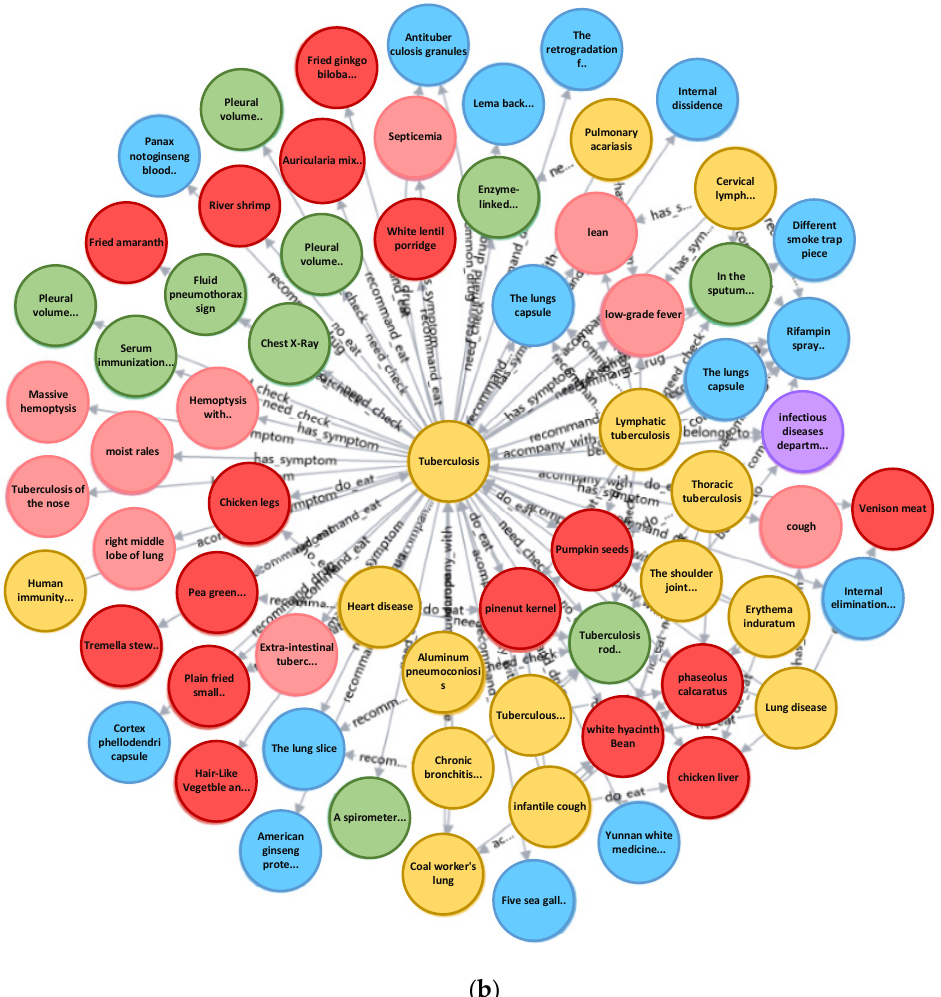
Figure 7. The Medical Knowledge Graph. ( a ). Visualization of DIK Medical Knowledge Graph from Multi-Data Source; ( b ). Medical Data Fusion from Di ff erent Data Sources.